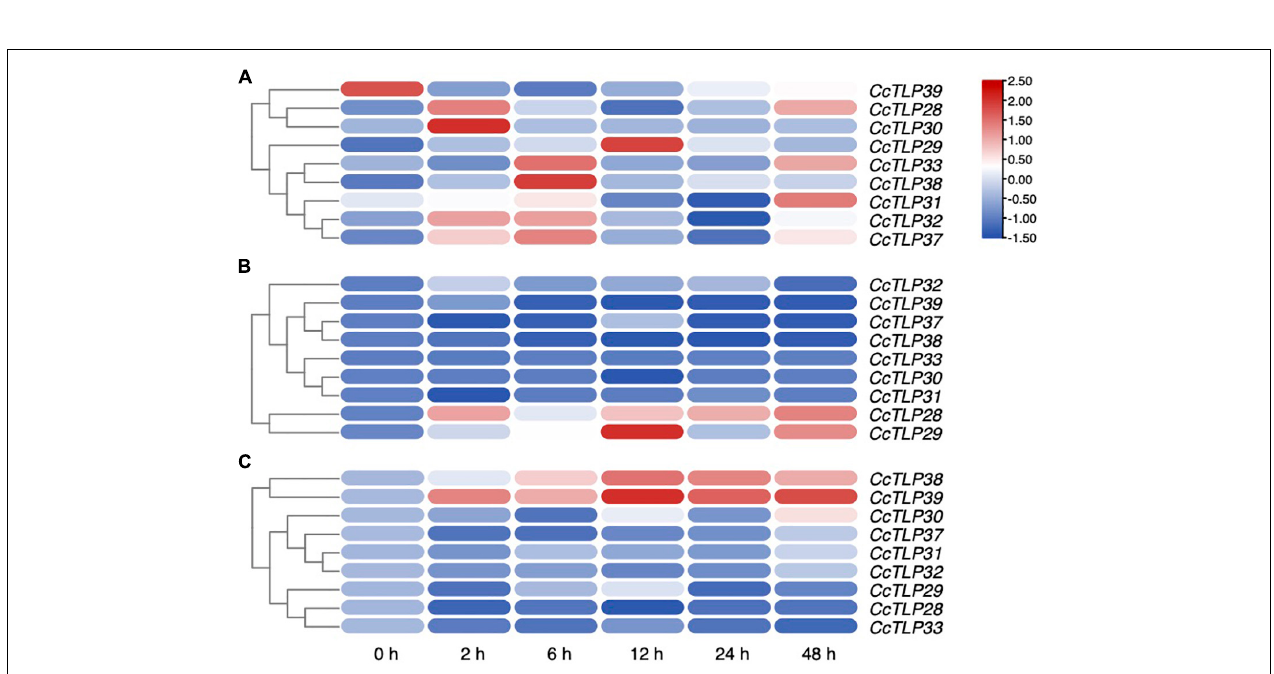
FIGURE 6 | The expression patterns of nine CcTLP genes after plant hormones treatments. The relative expression of nine CcTLP genes after treatments with SA, MeJA, and ETH for 0, 2, 6,12, 24, and 48 h were calculated using quantitative real-time polymerase chain reaction (qRT-PCR) analysis. The expression level was represented by the mean relative expression value. The relative expression level of CcTLP genes was calculated by the standard curve and then normalized by the CcActin expression level. R-package pheatmap were utilized to plot the expression heatmap of CcTLPs after treatments with salicylate (SA), methyl jasmonate (MeJA), and ethephon (ETH) for 0, 2, 6, 12, 24, and 48 h. Color bar in the diagram showed the range of normalized signal intensities.